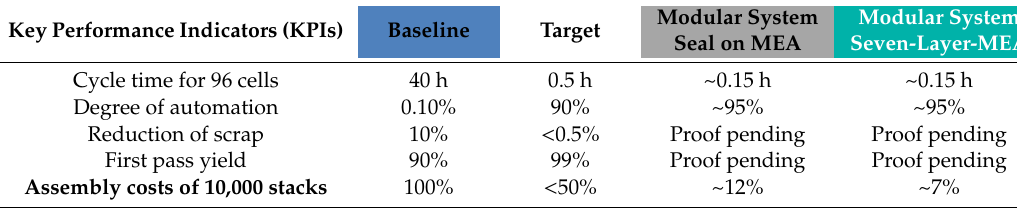
Table 4. Comparison of different automated stack assembly variants.